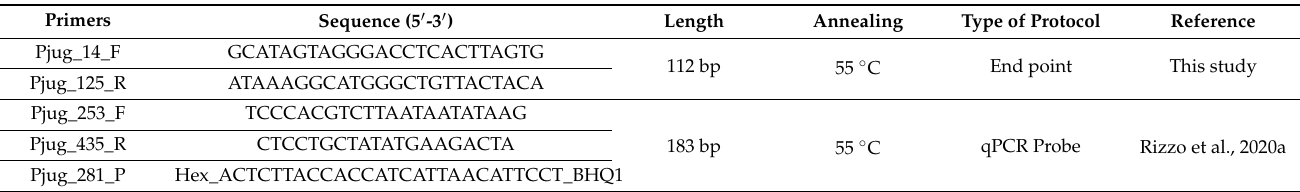
Table 6. Conventional PCR and qPCR protocols used for diagnostic comparisons with the LAMP assay. 1 5 (cid:48) -Hexachloro- Fluorescein-CE Phosphoramidite (HEX); 2 Black Hole Quancher 1 (BHQ1).